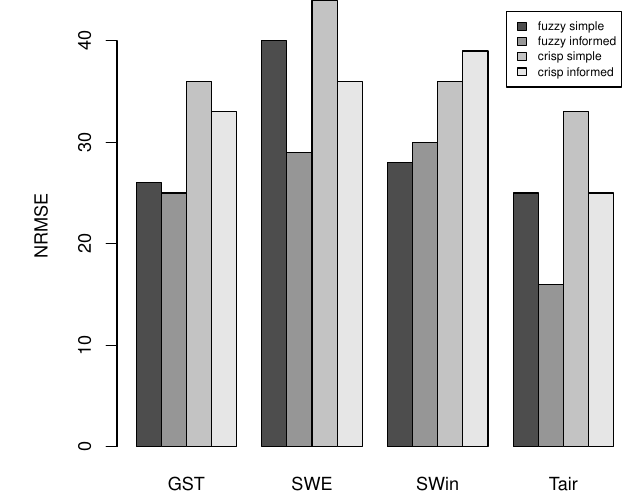
Fig. 14. NRMSE for 128 sample TopoSUB simulations for configu- rations: “fuzzy informed”, “fuzzy simple”, “crisp informed”, “crisp simple”. All TV results improve with fuzzy membership. All TV results except SWin improve with informed